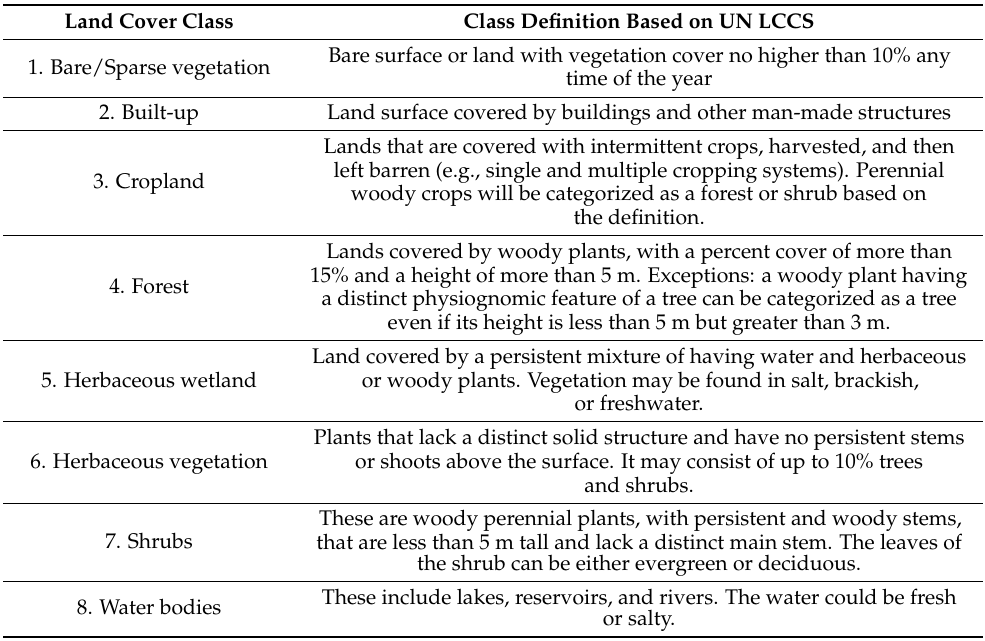
Table 2. Land cover classes and their definition modified after Smets et al. [7].